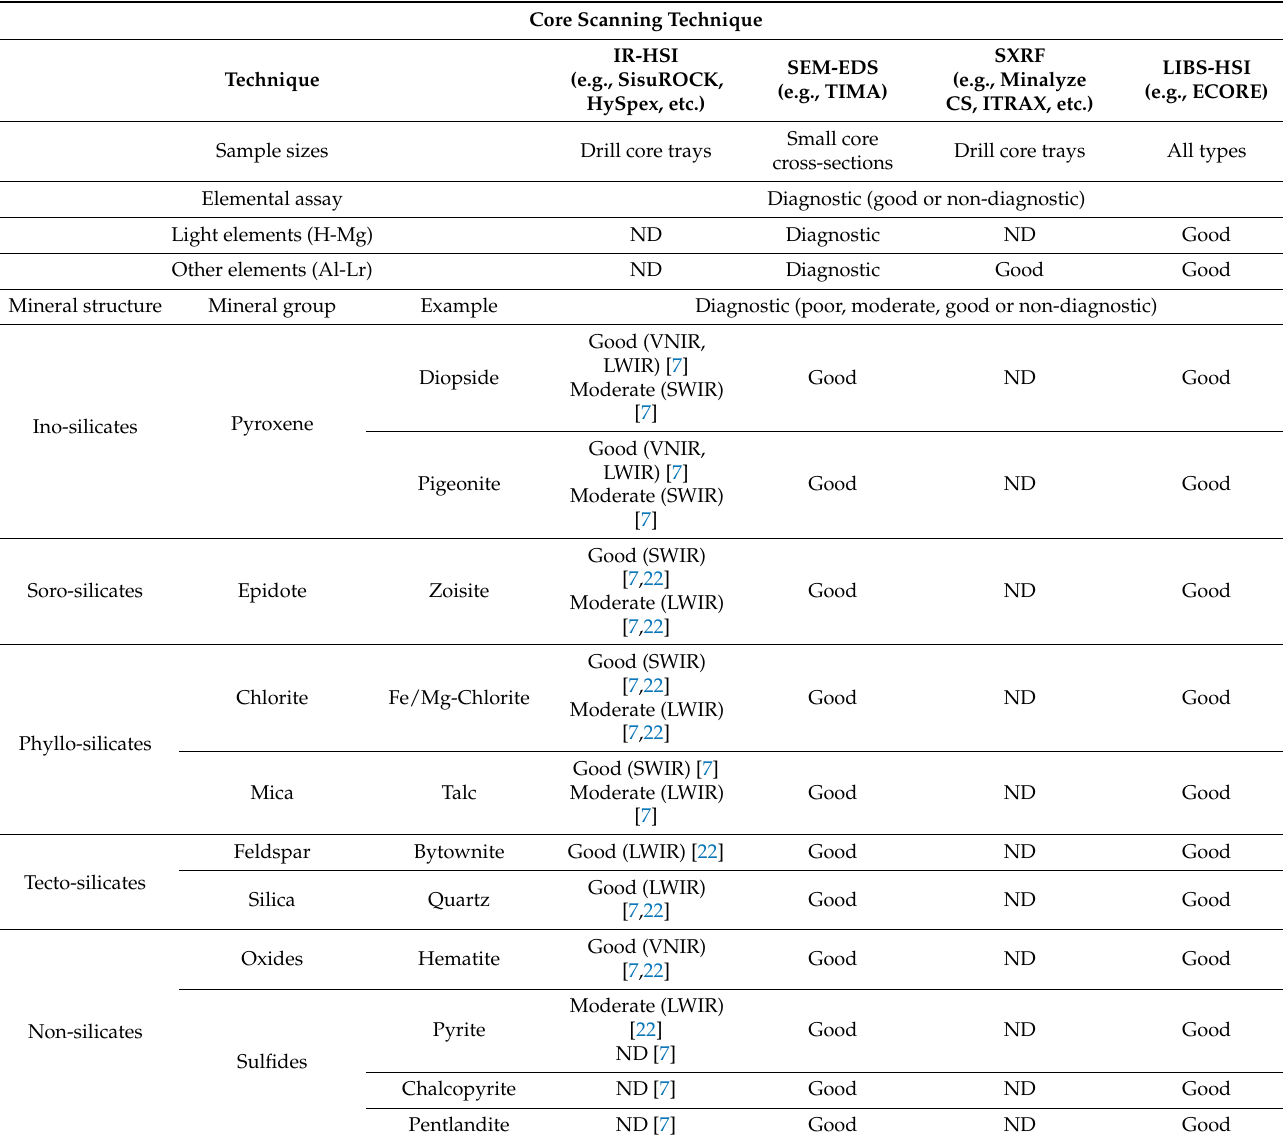
Table 3. Comparison of three types of drill core scanners (IR-HSI, SXRF, and LIBS) and a SEM-EDS high-resolution